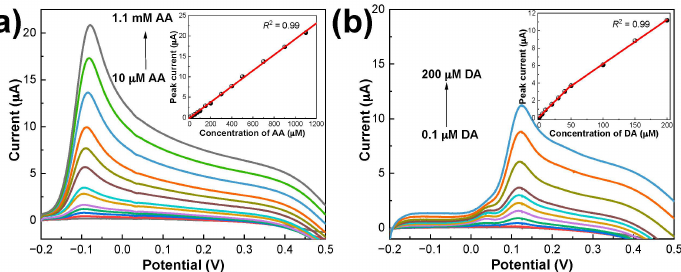
Figure 4. LSV curves for PD b S–rGO/SPCE in ( a ) 10 µ M to 1.1 mM AA; ( b ) 0.1 µ M to 200 µ M DA prepared in 50 mM PBS (pH 7.0). Insets: Plots of anodic peak current against the concentrations of AA and DA, respectively.